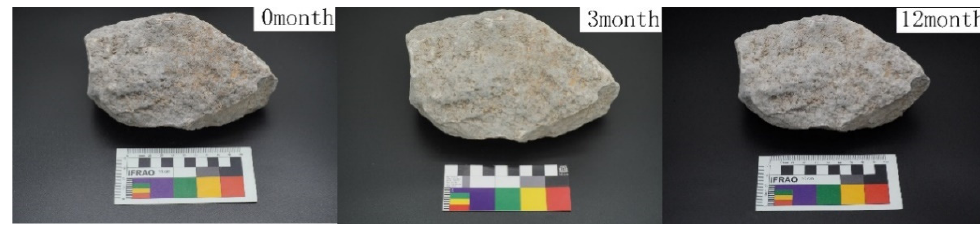
Figure 5. SEM microscope of test samples after treatment with simulated acid rain at different pH values. Figure 6. Field exposure results after one year. Figure 6. Field exposure results after one